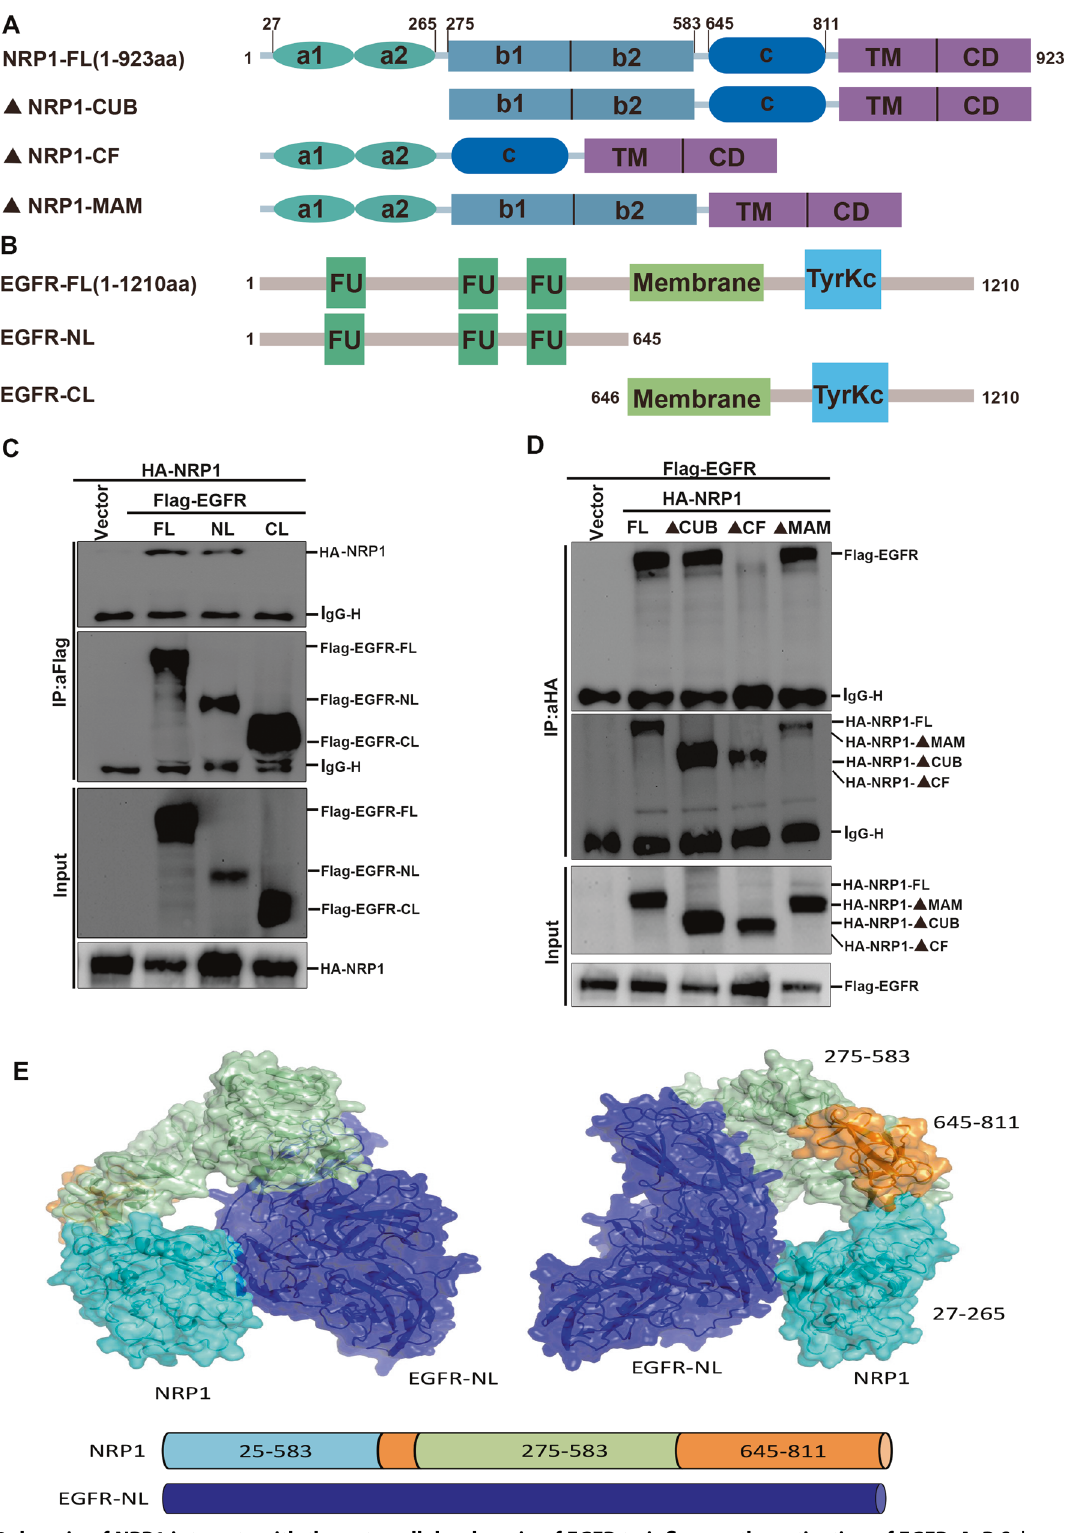
Fig. 6 b1/b2 domain of NRP1 interacts with the extracellular domain of EGFR to in fl uence the activation of EGFR. A , B Schematic diagram of NRP1 and EGFR primary structure and truncated plasmids construction. C Identi fi cation of the b1/b2 domain of NRP1 mediating its interaction with EGFR. D Identi fi cation of the extracellular domain of EGFR mediating its interaction with NRP1. E Molecular docking analysis shows the interaction domain between NRP1 and EGFR.